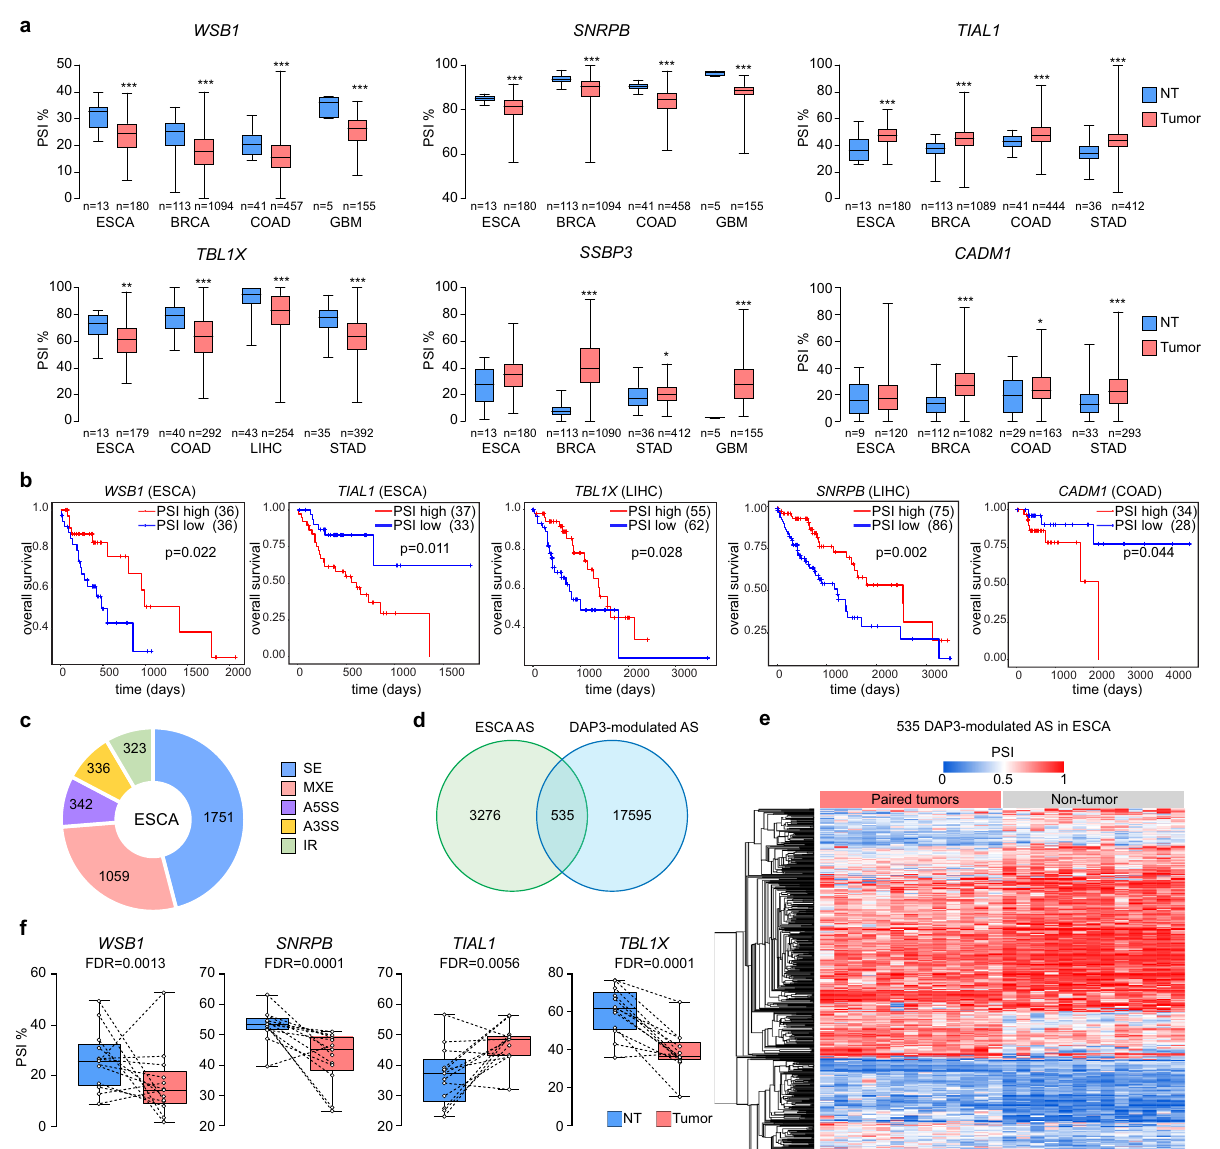
Fig. 6 Clinical relevance of DAP3-modulated mis-splicing in multiple cancer types. a Boxplots showing the PSI values of six experimentally validated DAP3-modulated splicing events in tumors and their matched NT samples of six representative TCGA cancer types including esophageal carcinoma (ESCA), breast invasive carcinoma (BRCA), colon adenocarcinoma (COAD), glioblastoma multiforme (GBM), liver hepatocellular carcinoma (LIHC), and stomach adenocarcinoma (STAD). Statistical signi fi cance was determined by two-tailed nonparametric Mann – Whitney test (* p < 0.05, ** p < 0.01, *** p < 0.001). b Kaplan – Meier OS plots comparing patients demonstrating the top 25th percentile of PSI values of the indicated DAP3-modulated splicing events ( “ PSI high ” group) and those with the bottom 25th percentile of PSI values ( “ PSI low ” group). Statistical signi fi cance was determined by log-rank test. c Pie chart showing the distribution of each type of differentially spliced events in 13 matched pairs of ESCA tumors and their NT samples detected by rMATS analysis 15 . d Venn diagram showing the number of signi fi cantly altered spliced events identi fi ed by RNA-Seq analysis of both DAP3 -depleted ESCC cells (EC109 and KYSE180) and the TCGA ESCA. e Heatmap showing 535 signi fi cantly altered DAP3-modulated splicing events detected in both ESCC cell lines and ESCA tumors as described in d . The heatmap was generated using hierarchical clustering of tumors and NT samples (average linkage and Euclidean distance used). The color spectrum indicates PSI values. f Boxplots showing the PSI values of four representative DAP3-modulated splicing events in 13 matched pairs of ESCA tumors and NT tissues. a, f The box extends from the 25th to 75th percentiles. The line in the middle of the box is plotted at the median. The whiskers indicate min to max. Exact p -values and source data are provided in Source Data fi